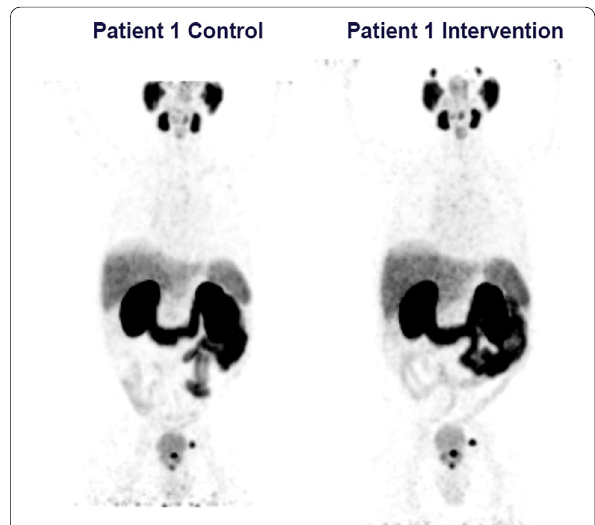
Fig. 1 Coronal maximum intensity projections of the control and intervention 68 Ga‑PSMA‑11 PET scans of patient 1